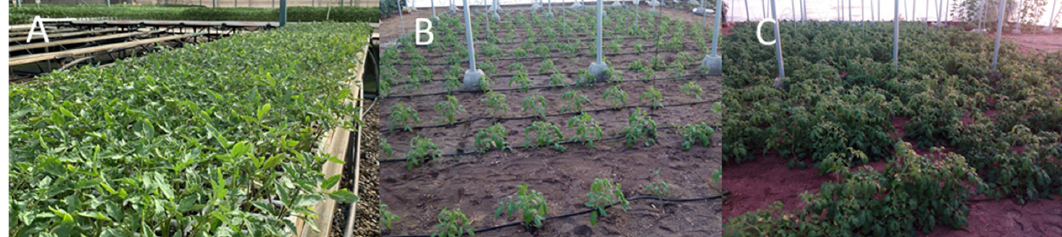
Figure 2. Tomato plants grown under commercial seedlings ( A ) and field assay, 30 ( B ) and 60 ( C ) days after transplanting.